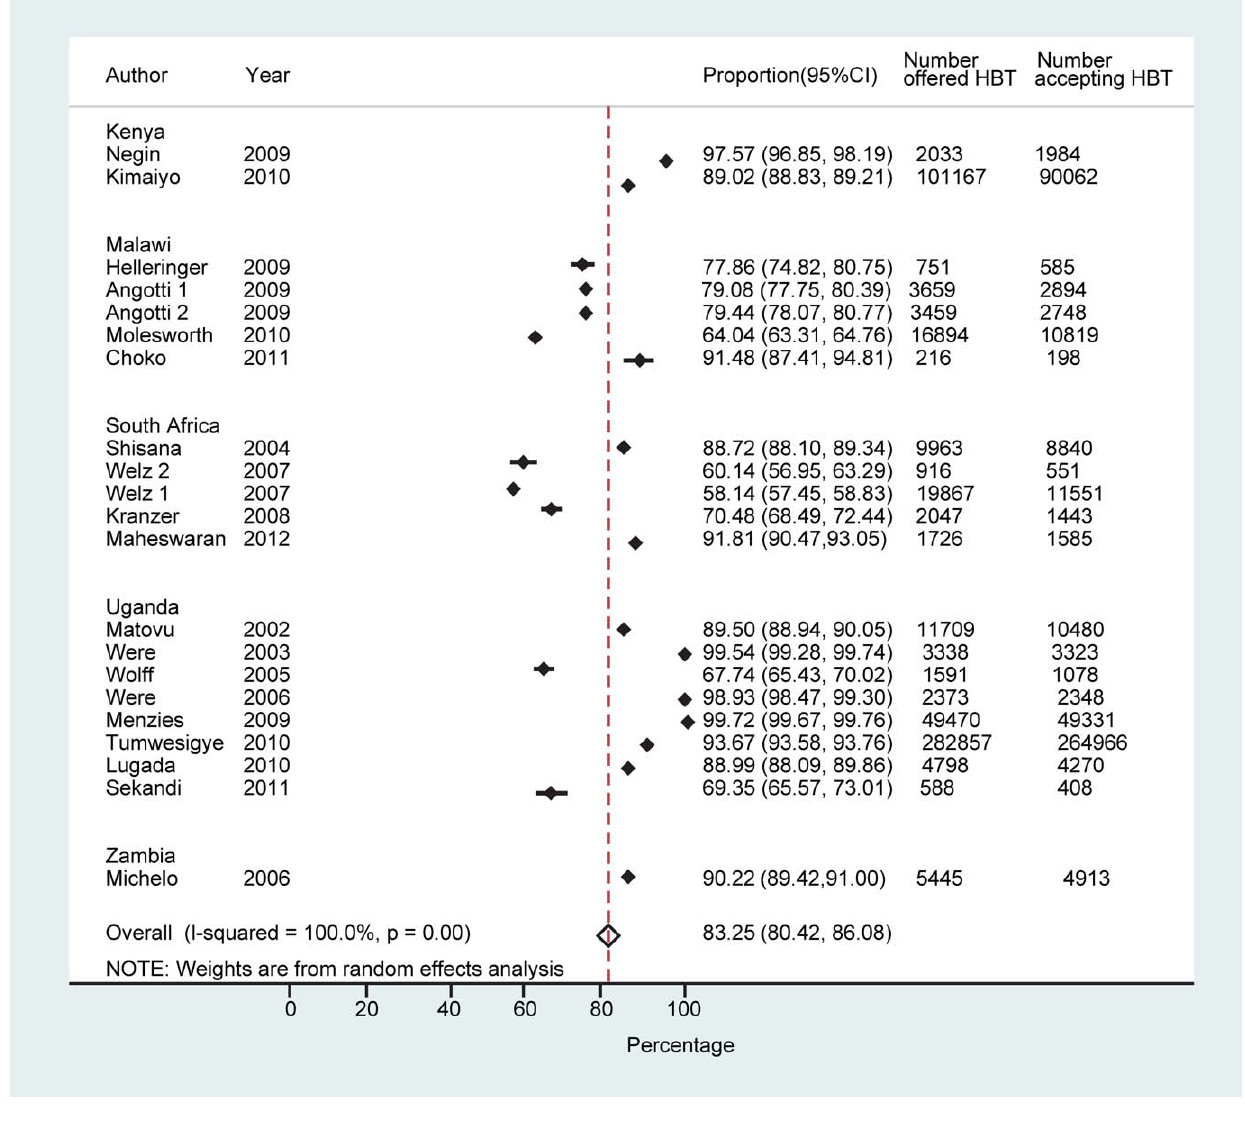
Figure 2. Proportion accepting HBT.